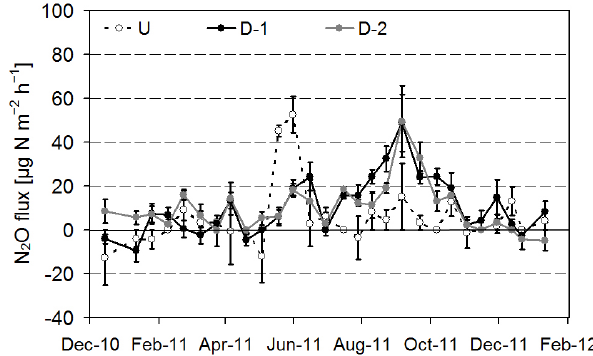
Figure 5. Mean ( ± SE, n = 3) N 2 O fluxes of the undrained (U), drained 1 (D-1) and drained 2 (D-2) sites. Please note that the x axis starts on 1 December 2010.